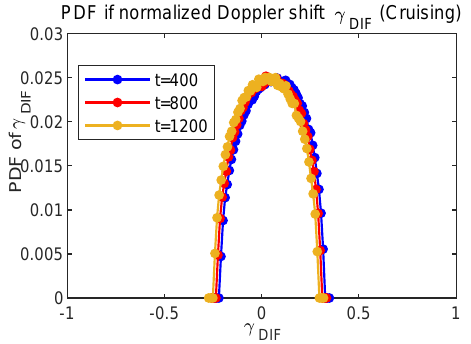
Figure 14. The PDFs of normalized Doppler shift (Rising).